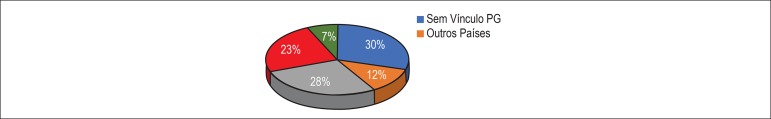
Origin of Publications (2010-2017)